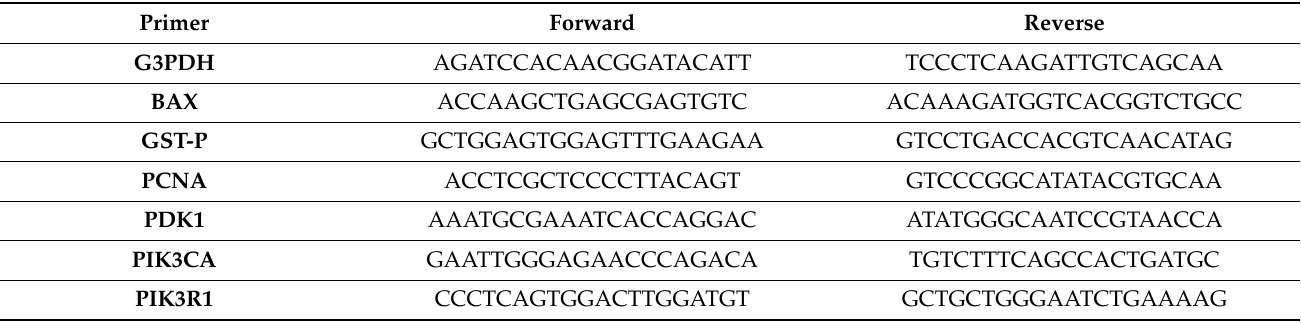
Table 1. Sequence of selected primers in this